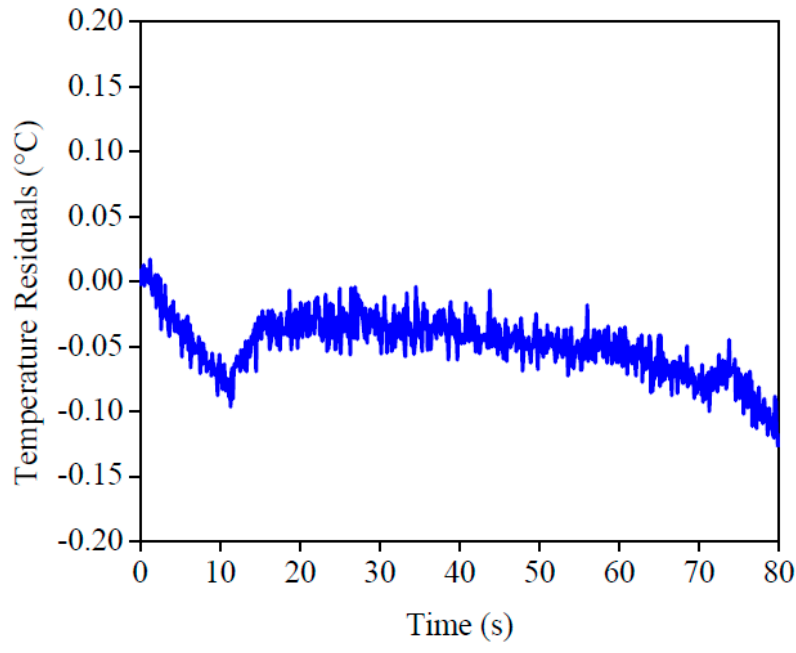
Figure 6. Experimental heat flow ( φ ) for AISI 1045. Comparison of temperatures obtained numerically ( T ) and experimentally ( Y ).